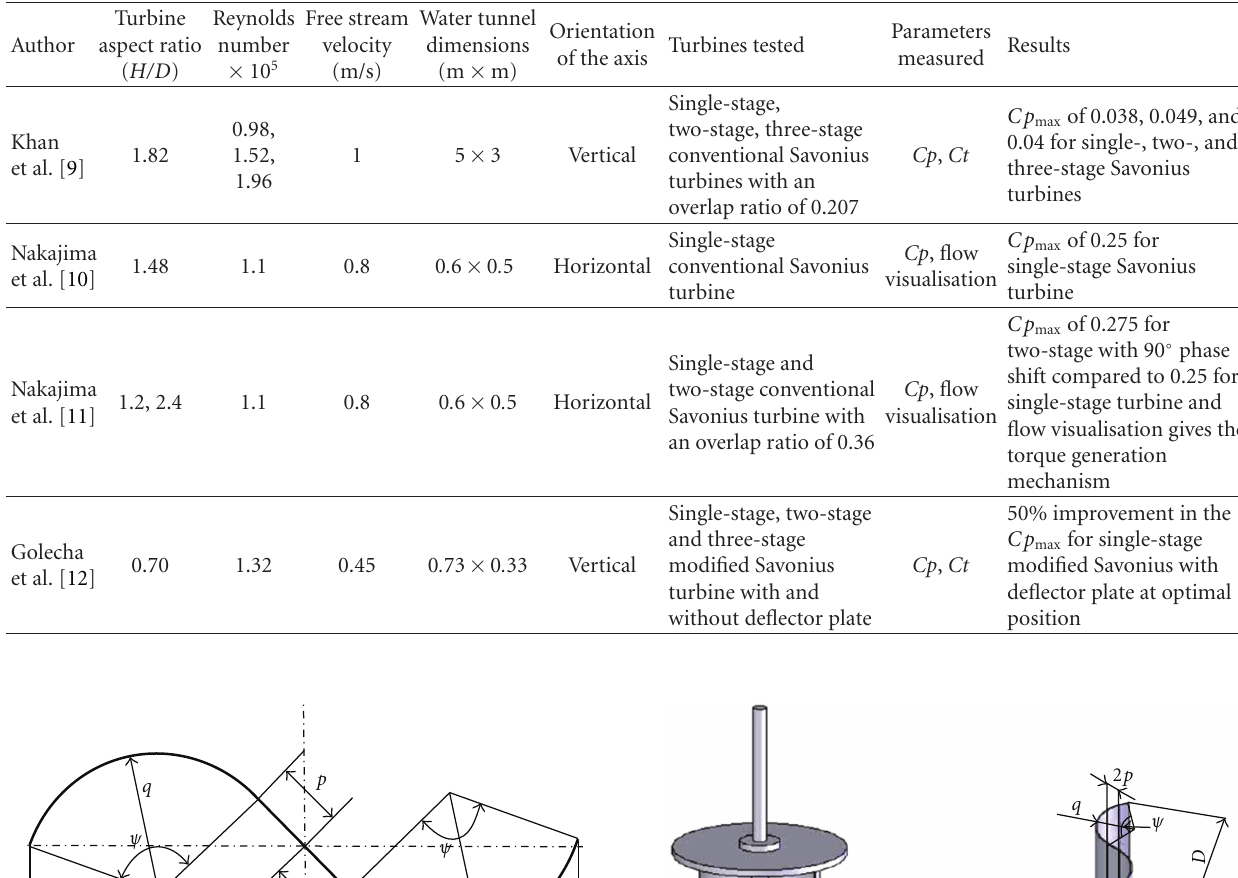
Table 1: Summary of experimental investigation carried out by researchers on Savonius turbines with water as working medium.